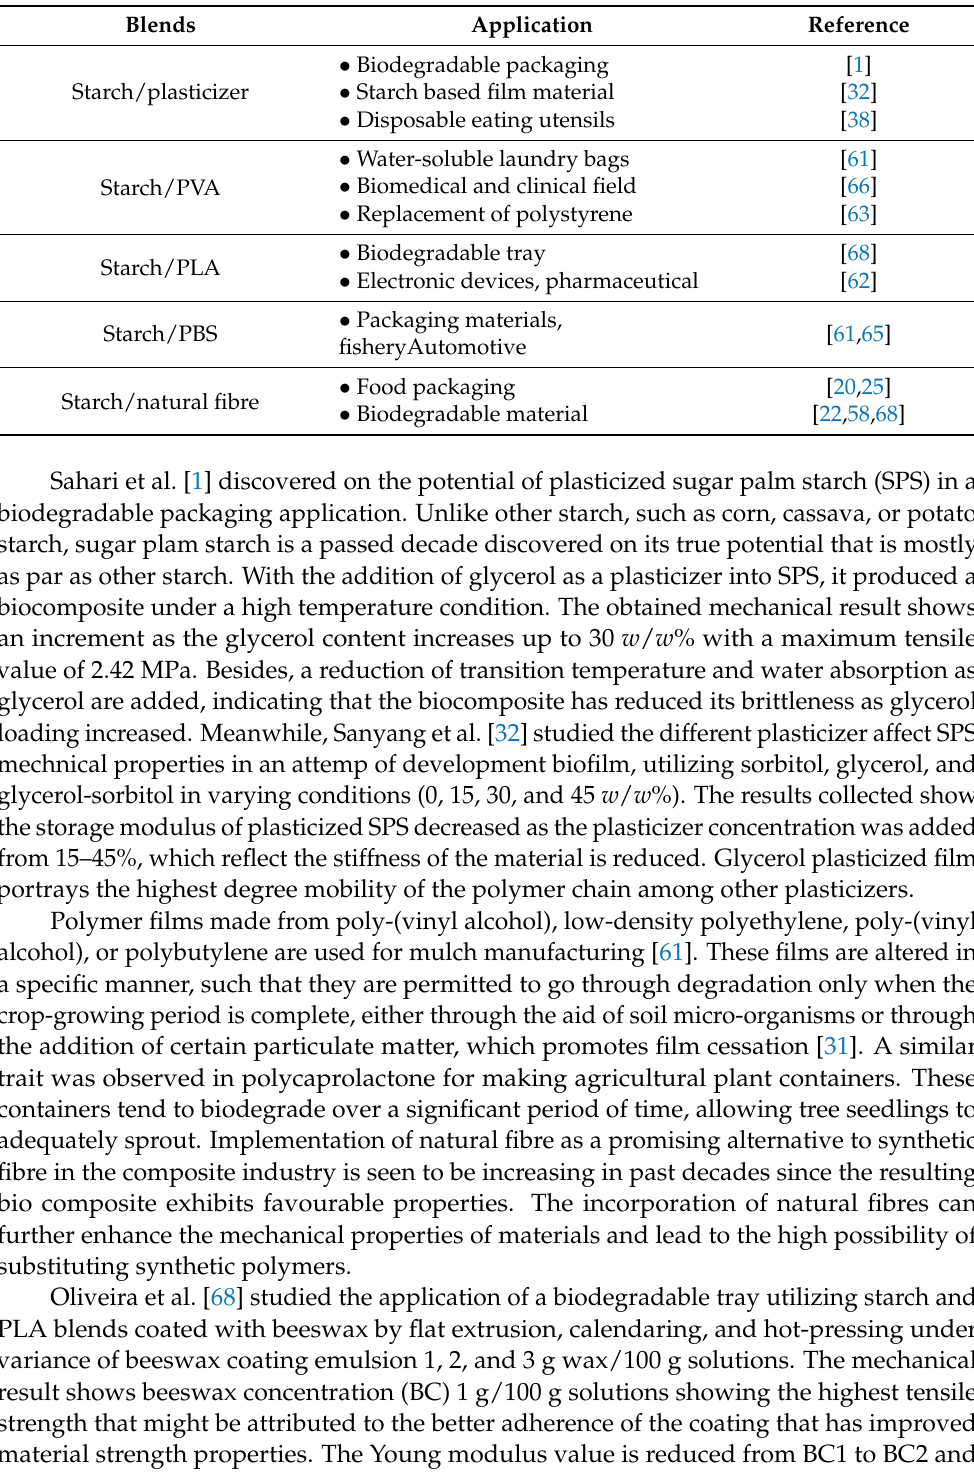
Table 6. Applications of